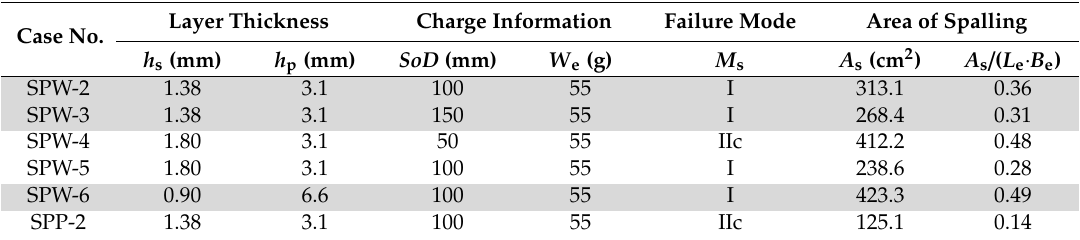
Table 6. Measurements of spalling on the polyurea backing layers in the present experiments. Case